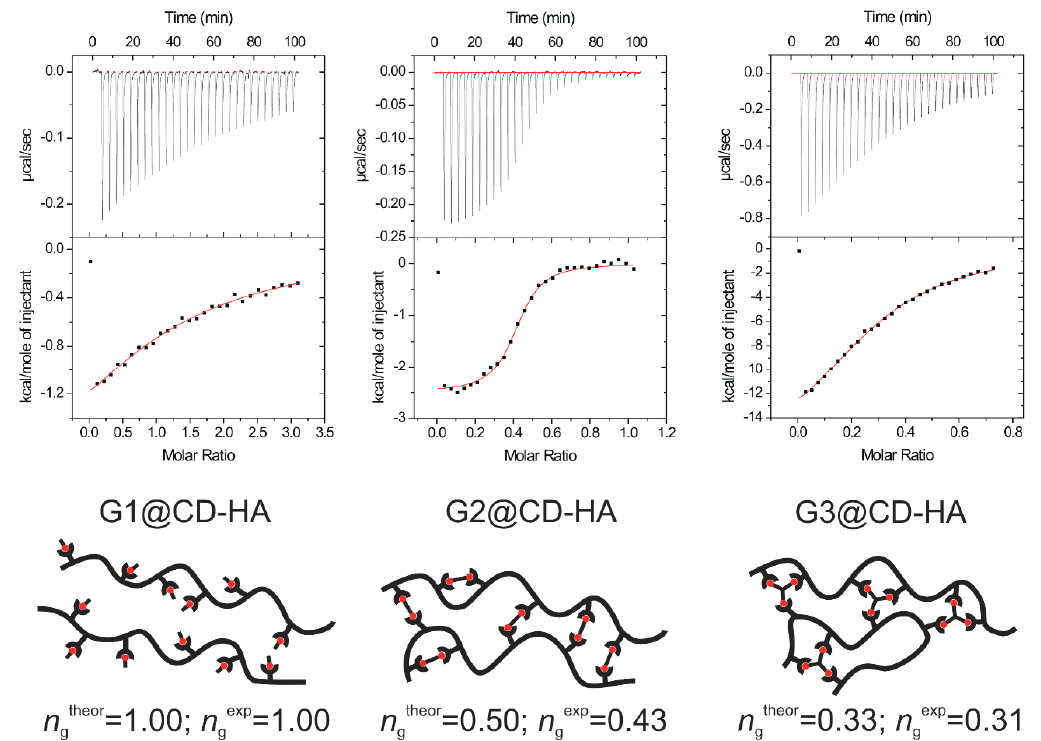
Figure 2. ITC results and interpretation of titrations of CD-HA with guests G1 , G2 , and G3 .